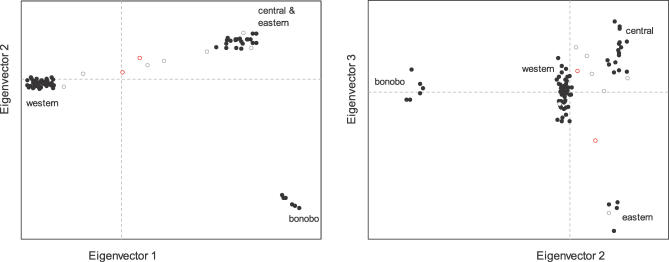
PCA, Without Using Population Labels, Divides the 84 Chimpanzees into Four Apparently Discontinuous Populations of Western, Central, Eastern, and BonoboPlots of eigenvectors 1 versus 2, and eigenvectors 2 versus 3, show clustering into populations, with the expected assignments for the 75 individuals identified as all of one ancestry by STRUCTURE (solid circles). The nine individuals identified by STRUCTURE as hybrids (open circles) are for the most part identified as hybrids by PCA as well. There are two individuals (red open circles) reported as being of a particular population but that in fact appear to be hybrids: number 23, reported as eastern but in fact a western-eastern hybrid, and number 54, a wild-born individual reported as western but in fact a western-central hybrid.